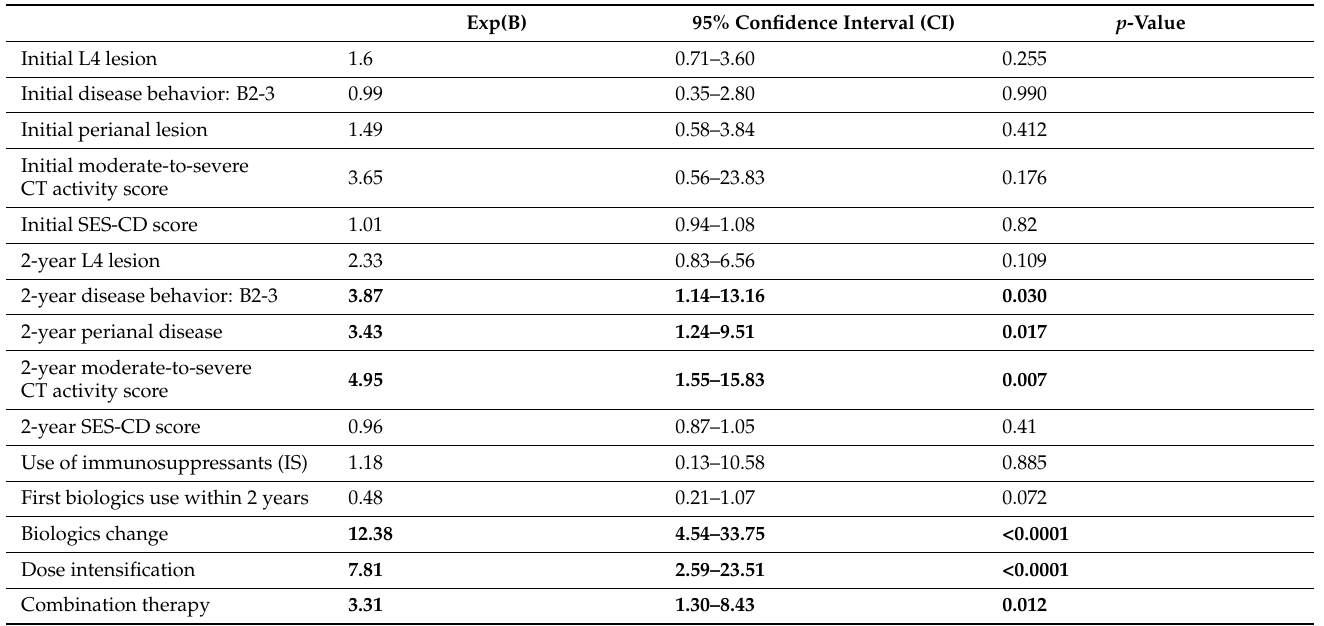
Table 4. Multivariate regression analyses for unfavorable disease